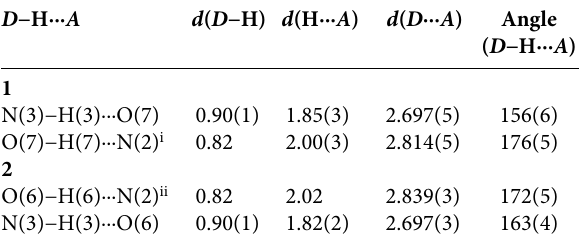
Table 3. Hydrogen bonding interactions (Å,